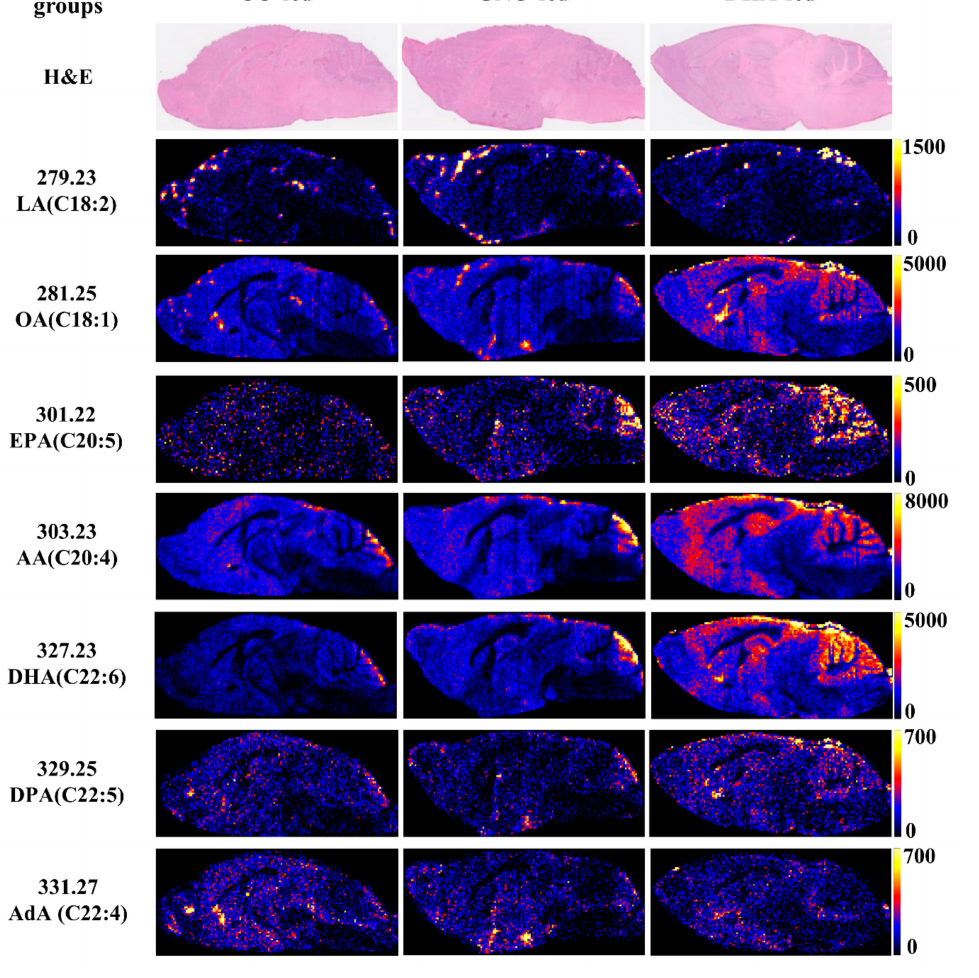
Figure 2. Selected molecular ion (M-H) - images of free fatty acids in sagittal slices of SAMP8 mouse brains from DESI-IMS. LA: linoleic acid, OA: oleic acid, EPA: eicosapentaenoic acid, AA: arachidonic acid, DHA: docosahexaenoic acid, DPA: docosapentaenoic acid, AdA: adrenic